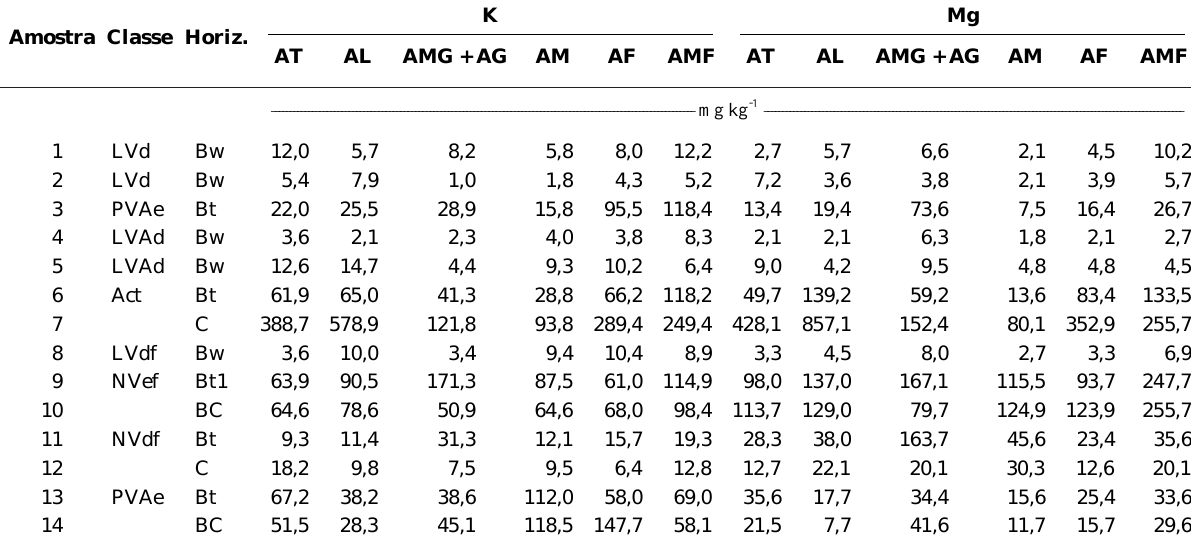
(1) AT-areia total; AL-areia leve; AM- areia média; AF-areia fina; AMF- areia muito fina; AMG + AG- areia grossa + areia muito grossa.